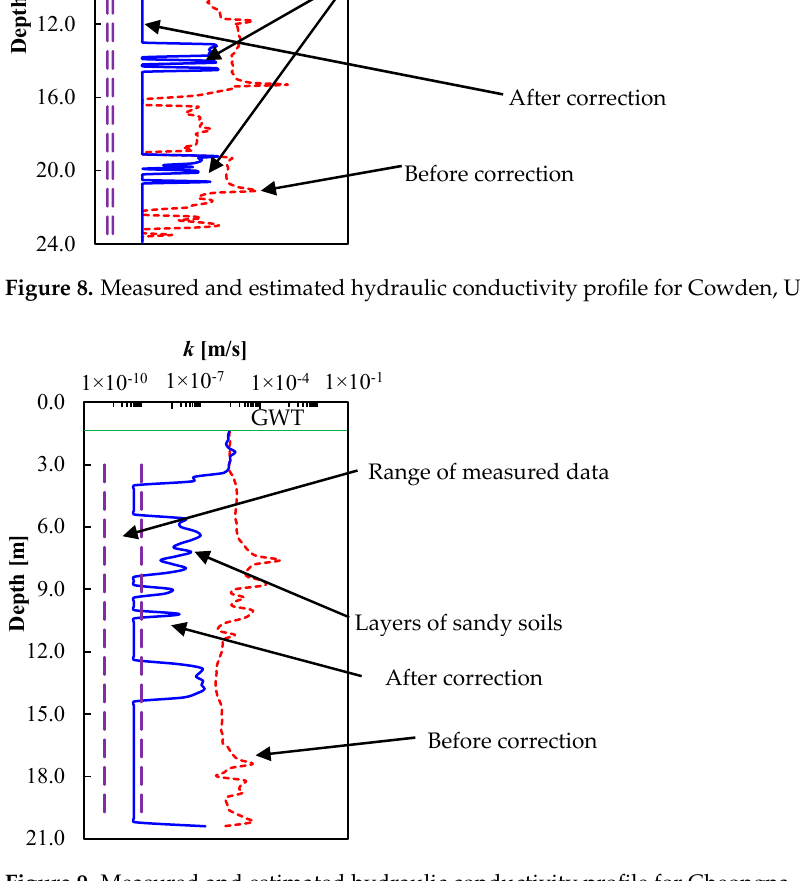
Figure 9. Measured and estimated hydraulic conductivity profile for Cheongna, Incheon site.